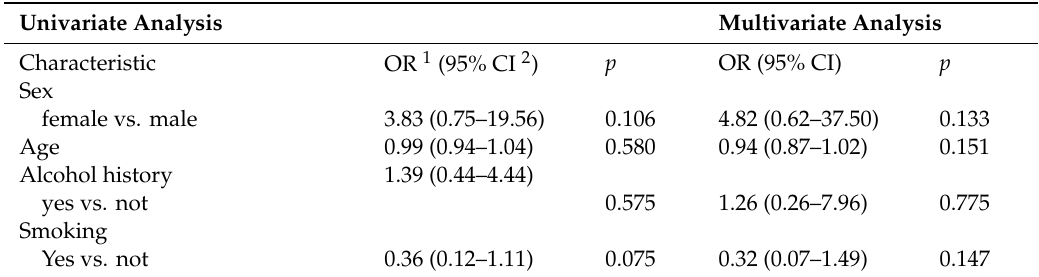
Table 2. Correlation between clinicopathological factors and early progression during